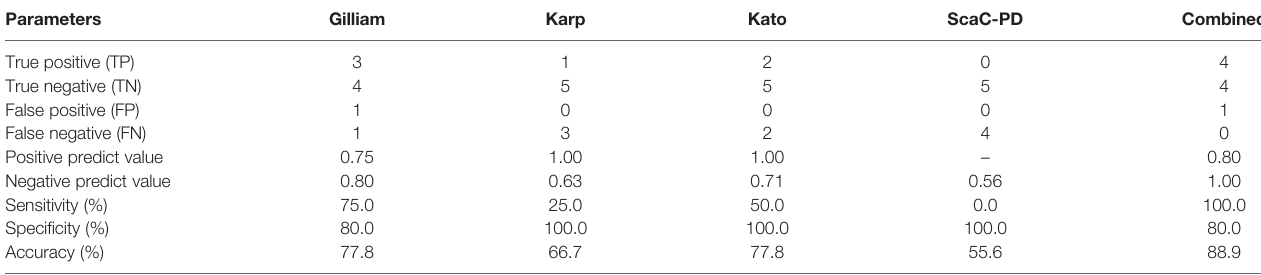
TABLE 5 | Detection ef fi ciency of the cell-based ELISA system in human serum sample diagnosis. Parameters